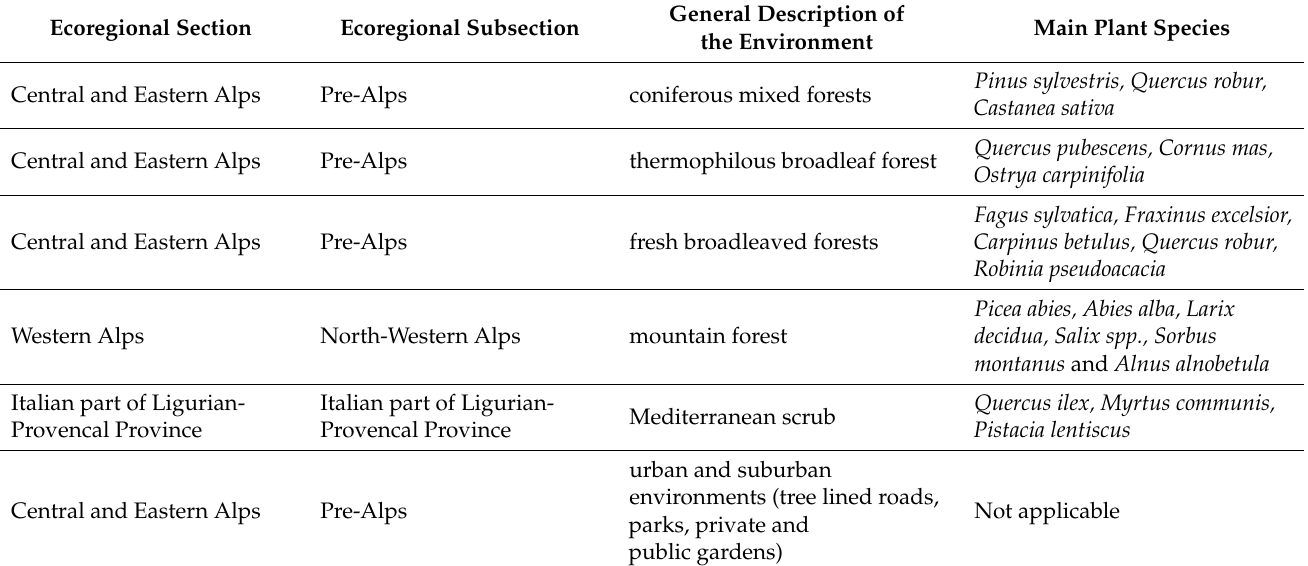
Table 1. Environments investigated for field sampling in northern Italy. Ecoregional sections and subsections, as in Blasi et al.